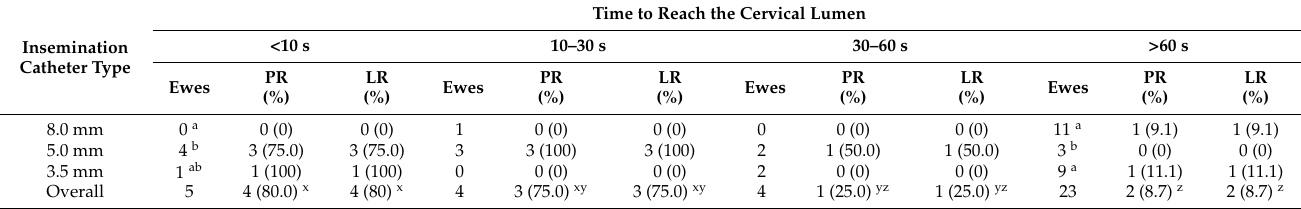
Table 3. Pregnancy (PR) and lambing (LR) rates in relation to the time taken to reach the cervical lumen using three different catheters.